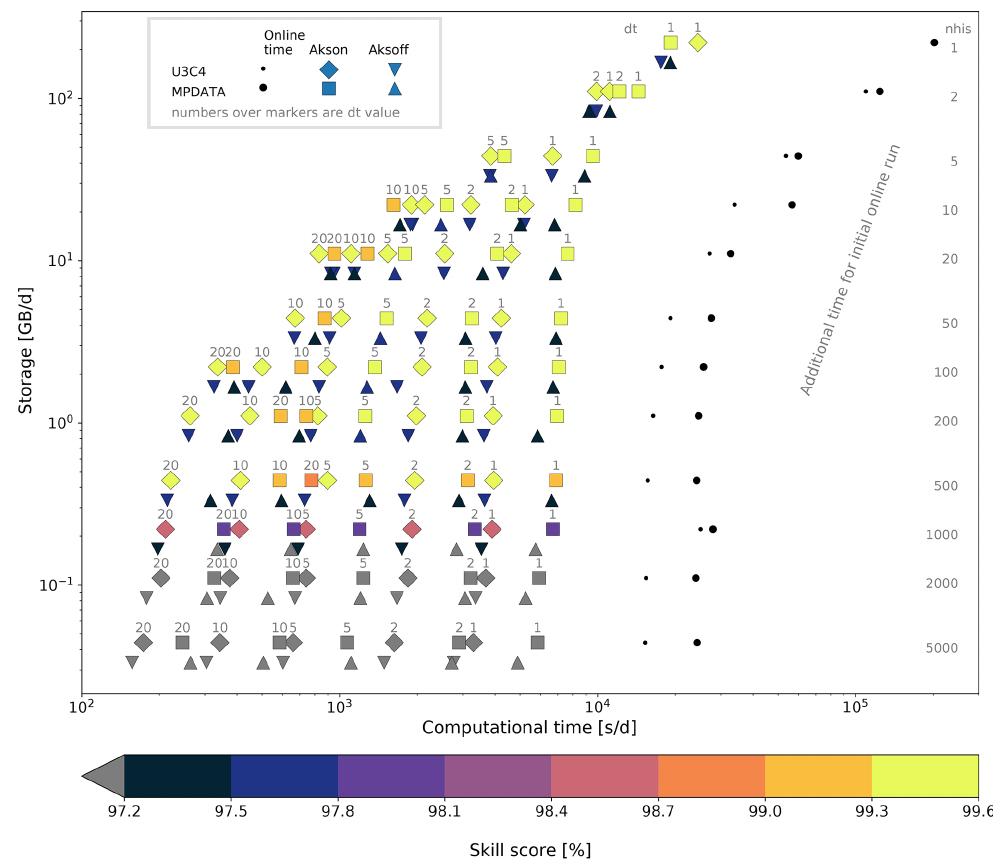
Figure 6. Summary of skill score results. Shown are the offline computational time per simulation day ( x axis), the storage required for the online simulation per simulation day ( y axis), and the skill score after about 13.5d of simulation when forcing with snapshots ( his files) for a range of nhis and dt values (colored markers, with one set for forcing Aks or not, and which tracer advection scheme is used). nhis values for rows are indicated on the right-hand side of the plot, and dt values are shown above each pair of markers. Values below 97.2% are colored gray. The computational time required for the online simulation is shown separately with black